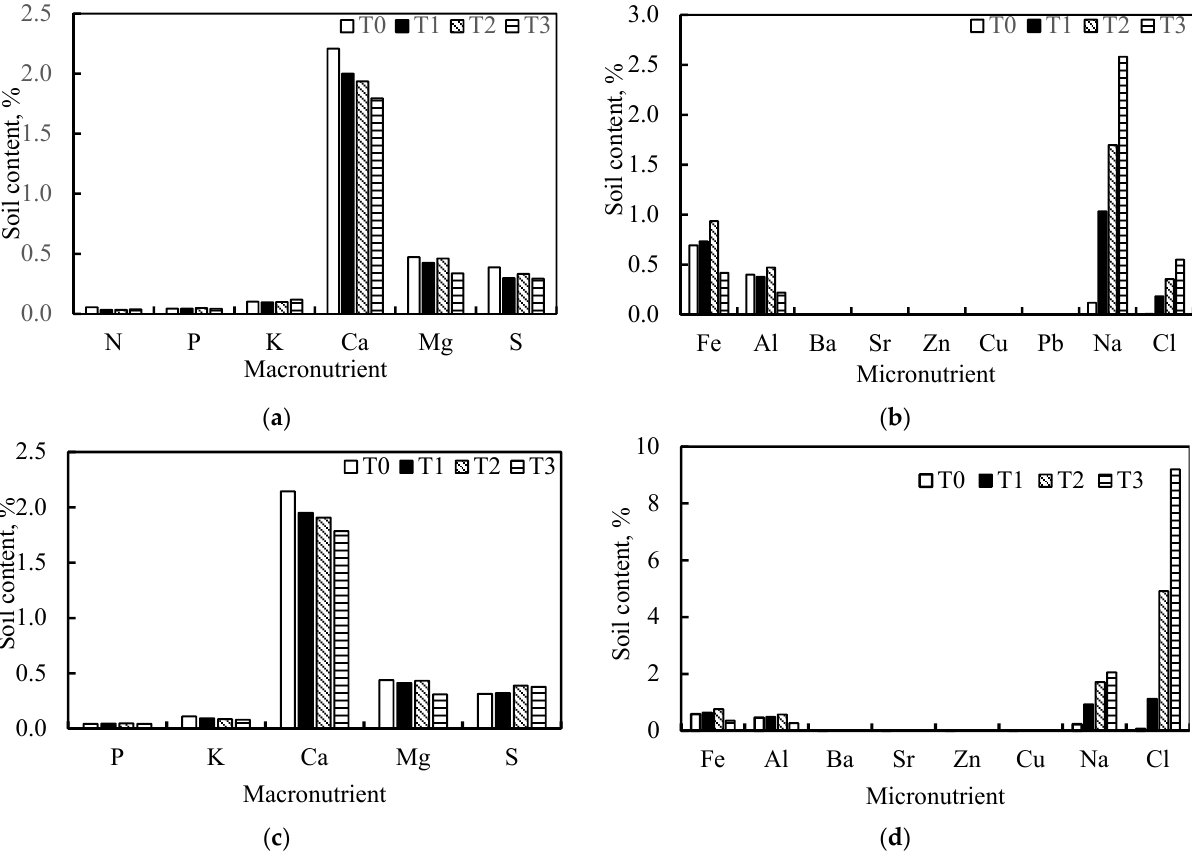
Figure 3. Macronutriment and micronutrient levels in soil ( a , b first experiment; c , d second